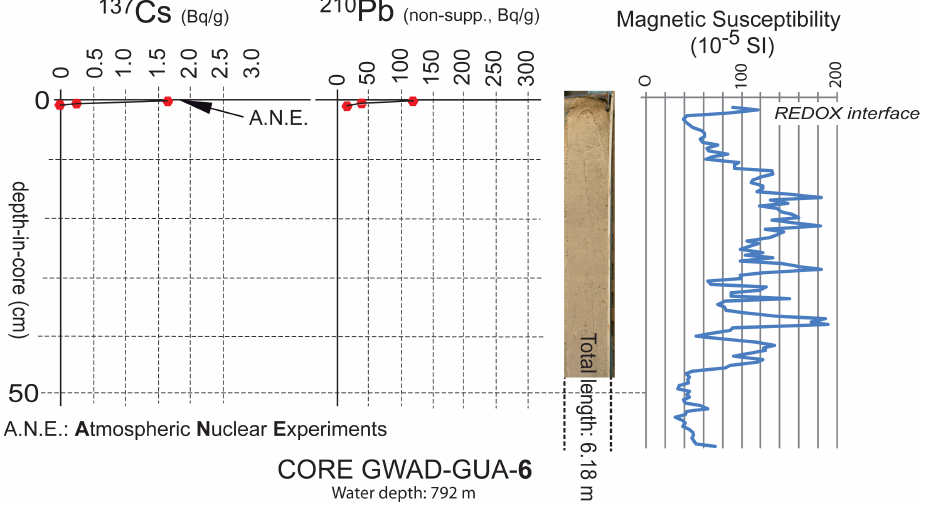
Fig. 5. Radionuclides and magnetic susceptibility profiles of Core GWAD-GUA 6. Only the brownish top 5cm were samples as supposed to represent the RedOx interface of a slow hemipelagic sedimentation. A slight coring-induced compaction and/or a slight erosion cannot be